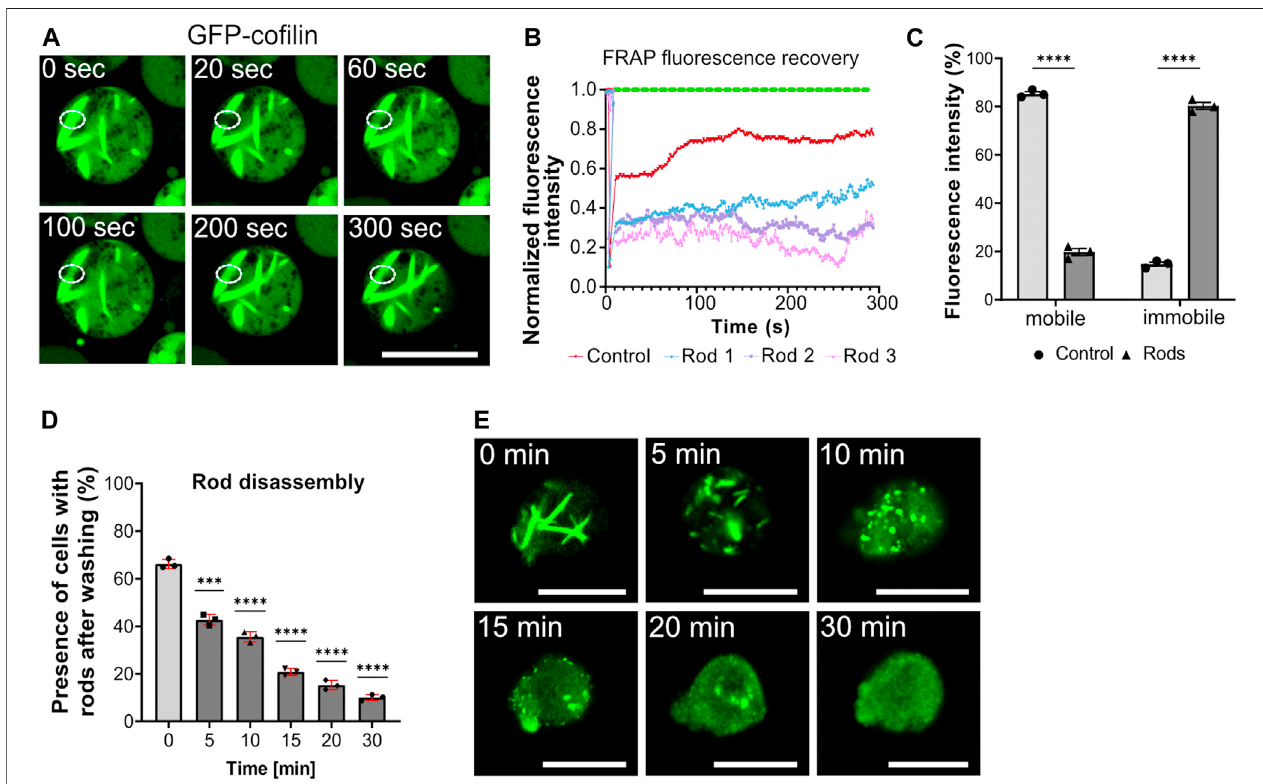
FIGURE2| Cytoplasmicactin-co fi linrodassembly/disassemblydynamics. (A) Fluorescencerecoveryafterphotobleaching(FRAP)ofcytoplasmicrods.Formation of cytoplasmic rods was induced by addition of 10 mM sodium azide for 60 min. Rods were selectively photobleached by drawing a ROI to apply high laser power for 10 stobleachtheGFP. The GFPdiffusion intotheROIarea( fl uorescence recovery)wasrecorded for300 s. Seealso Supplementary VideoS4 .Scale bar,10 µm. (B) Fluorescence recovery of photobleached rods. Bleaching curves of three different cytoplasmic rods of sodium azide-treated cells (blue, pink, purple lines) and the untreated control cell are plotted (red). (C) The histogram depicts the relative proportions of mobile and immobile fractions of cells without rods (control) and with cytoplasmic rods. The average of fl uorescence recovery was about 20%, indicating that rods are rather stable structures with low exchange inside the rod bundles. (D) Actin-co fi lin rods are rapidly disintegrating structures. After induction of cytoplasmic rods by addition of 10 mM sodium azide, the percentage of cells with cytoplasmic rodsdecreasesrapidlywhenthesodiumazideiswashedoutandreplacedbystandardmedium.Threeexperimentswereperformedandforeachexperimentatleast50 cells wereevaluated. Dataarepresented asmean ± SD(red bars).Statisticalsigni fi cance wascalculated byunpairedWelch´st-test. p ≤ 0.05wasconsidered signi fi cant and (*** p < 0.0001). (E) Visualization of actin-co fi lin rod disassembly stages. Within 30 min after wash-out of the sodium azide, actin-co fi lin rods are almost completely disintegrated. The disassembly takes place via shorter bundles and punctiform actin-co fi lin aggregates. Scale bars, 10 µm.